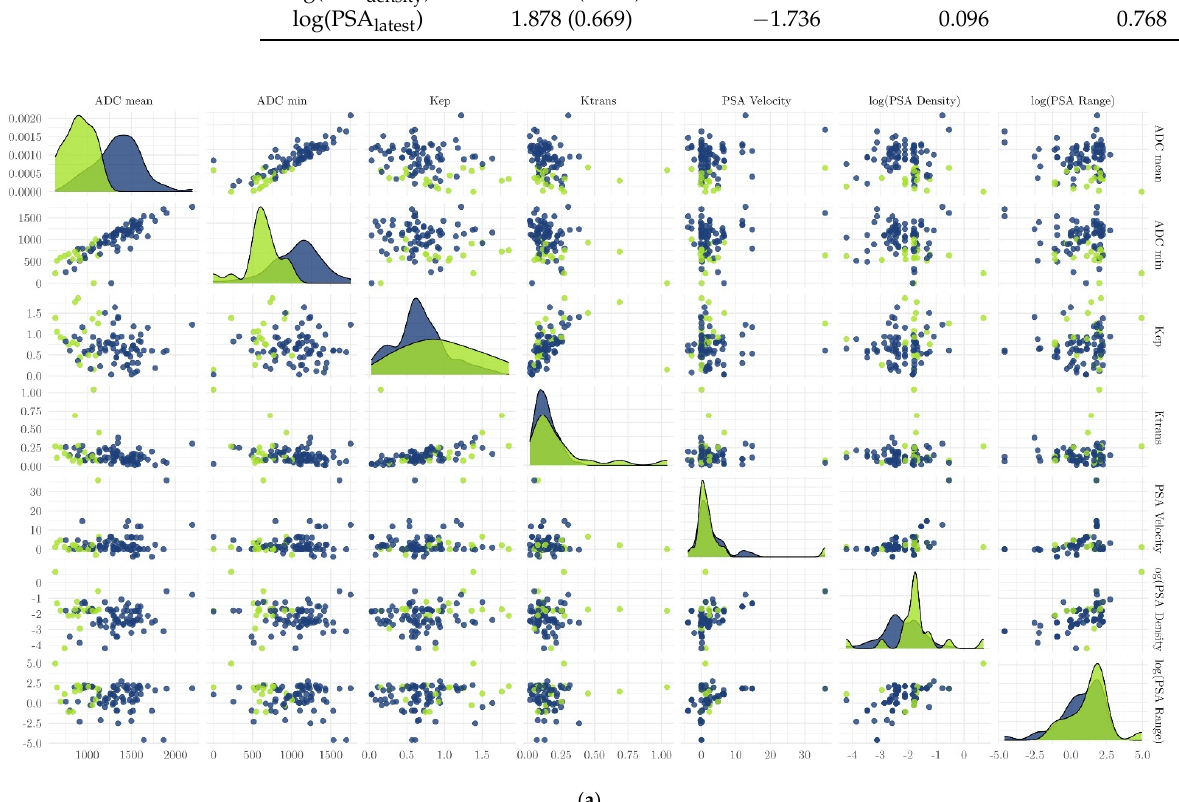
Table 4. Clinical and imaging parameters to discriminate csPCa and non-csPCa/no tumor. Variable Mean (SD) In the univariate assessment (ADC mean ), the sensitivity for csPCa was 1 for either no/mild prostatitis and severe prostatitis, with a specificity of 0.83 and 0.76, respectively. The ADC mean cutoff for differentiating between csPCa/non-csPCa was 0.9282 × 10 − 3 mm 2 /s for no/mild prostatitis and 0.9285 × 10 − 3 mm 2 /s for severe prostatitis. In the multivariate 266 assessment (ADC mean , K ep , and PSA density ), the sensitivity for csPCa was also 1 for either 267 no/mild prostatitis and severe prostatitis, with a specificity of 0.83 and 0.79, respectively. 268 Note that because of the small sample size (e.g., only five lesions with csPCa in the